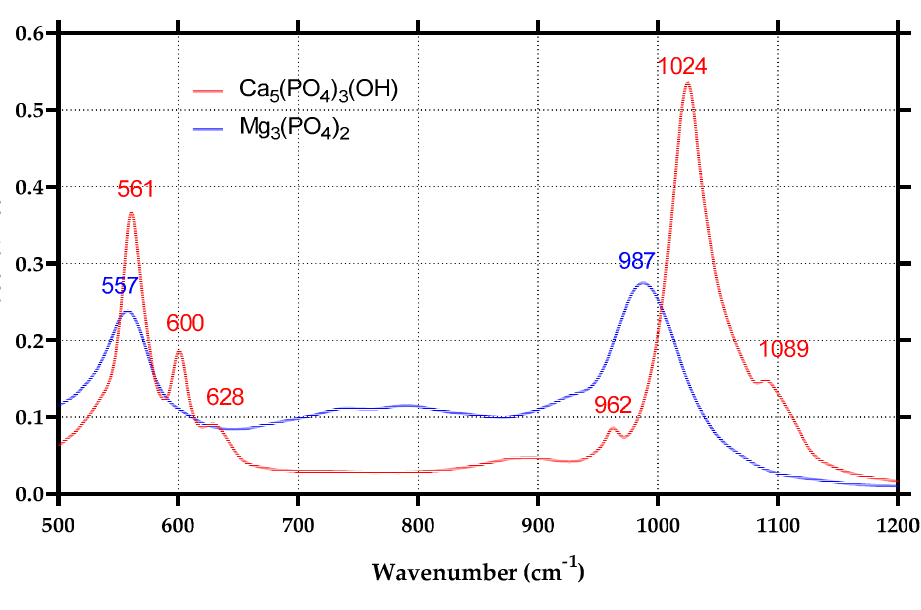
Figure 2. IR spectra of HA and MgP.